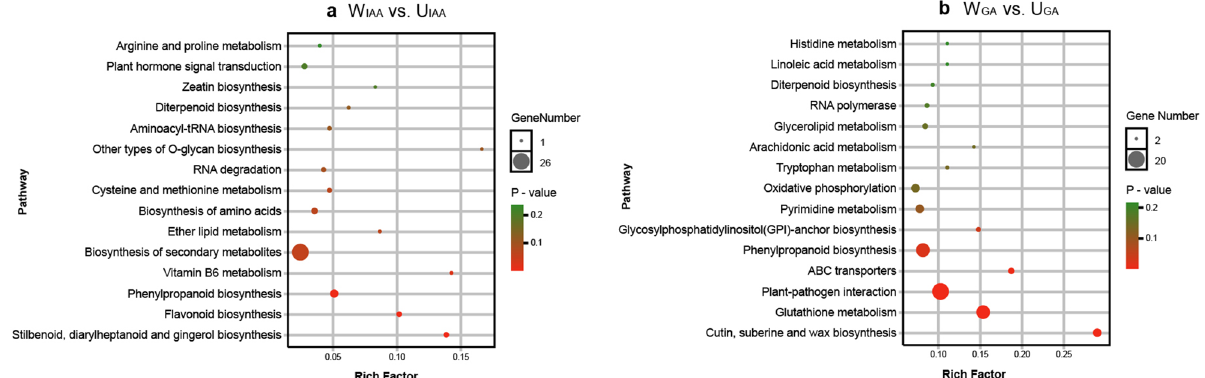
Figure 5. KEGG analyses reveal the differences in response of upright and weeping stems to IAA and GA treatments. ( a ) KEGG category enrichment of DEGs in W IAA vs. U IAA . ( b ) KEGG category enrichment of DEGs in W GA vs. U GA . The y-axis indicates the pathway, and the x-axis indicates the enrichment factors corresponding to the pathway. The dot size represents the number of DEGs in the pathway, and the dot colour represents the P